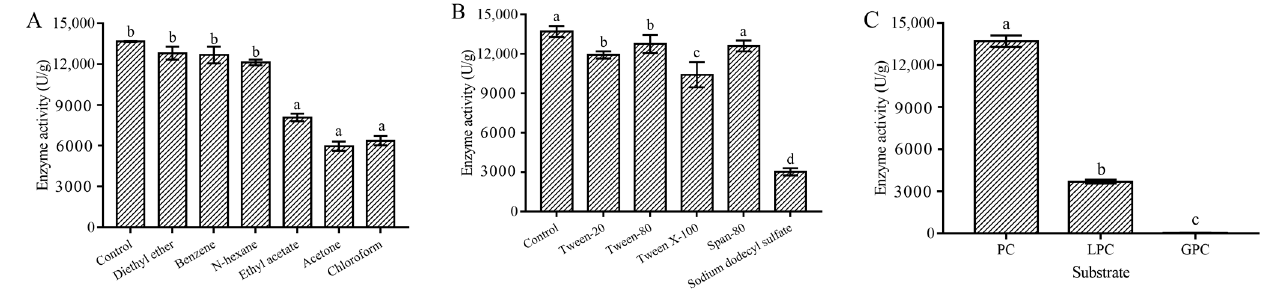
Figure 2. Enzymatic activities of wild-type MsPLD under different organic solvents ( A ), different surfactants ( B ), and different phospholipid substrates ( C ). Values are expressed as mean ± SD (bars) of three independent experiments. Different letters indicate that there was a significant difference between different groups ( p < 0.05).